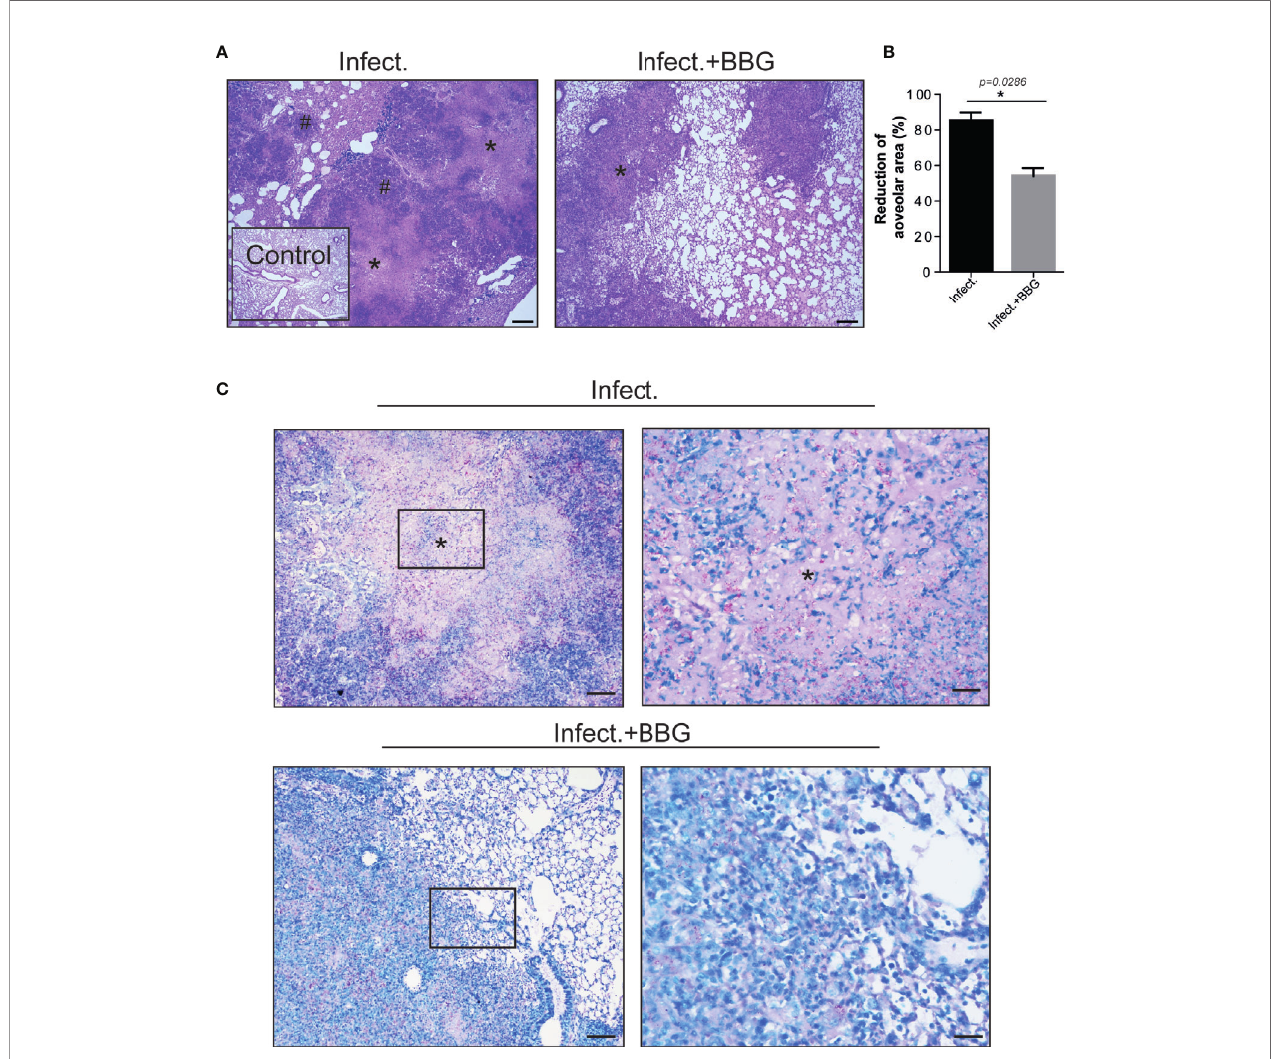
FIGURE 3 | P2X7 pharmacological blockade reduces tuberculous pulmonary lesions in mice. Histopathological changes in lungs of the BBG-treated and untreated mice, previously infected with ~100 MP287/03 bacilli, were evaluated at day 28 of infection. (A) Images of representative lung sections stained with hematoxylin- eosin method (scale bars correspond to 200 µm) are shown. Asterisks (*) indicate necrotic areas and hash signs (#) indicate alveolitis. (B) Morphometric quanti fi cation of aerated alveolar space is shown. (C) Images of representative lung sections stained with Ziehl Neelsen method. Magni fi ed areas from left squares are demonstrated in right images (scale bars correspond to 100 µm and 25 µm, respectively), showing large number of extracellular bacilli in necrotic regions (*) in untreated mice, whereas predominantly intracellular bacilli were seen in the BBG-treated mice. Signi fi cant differences were observed between indicated groups with * p < 0.05, using Mann-Whitney non-parametric T test. Data are representative of two independent experiments with four mice in each